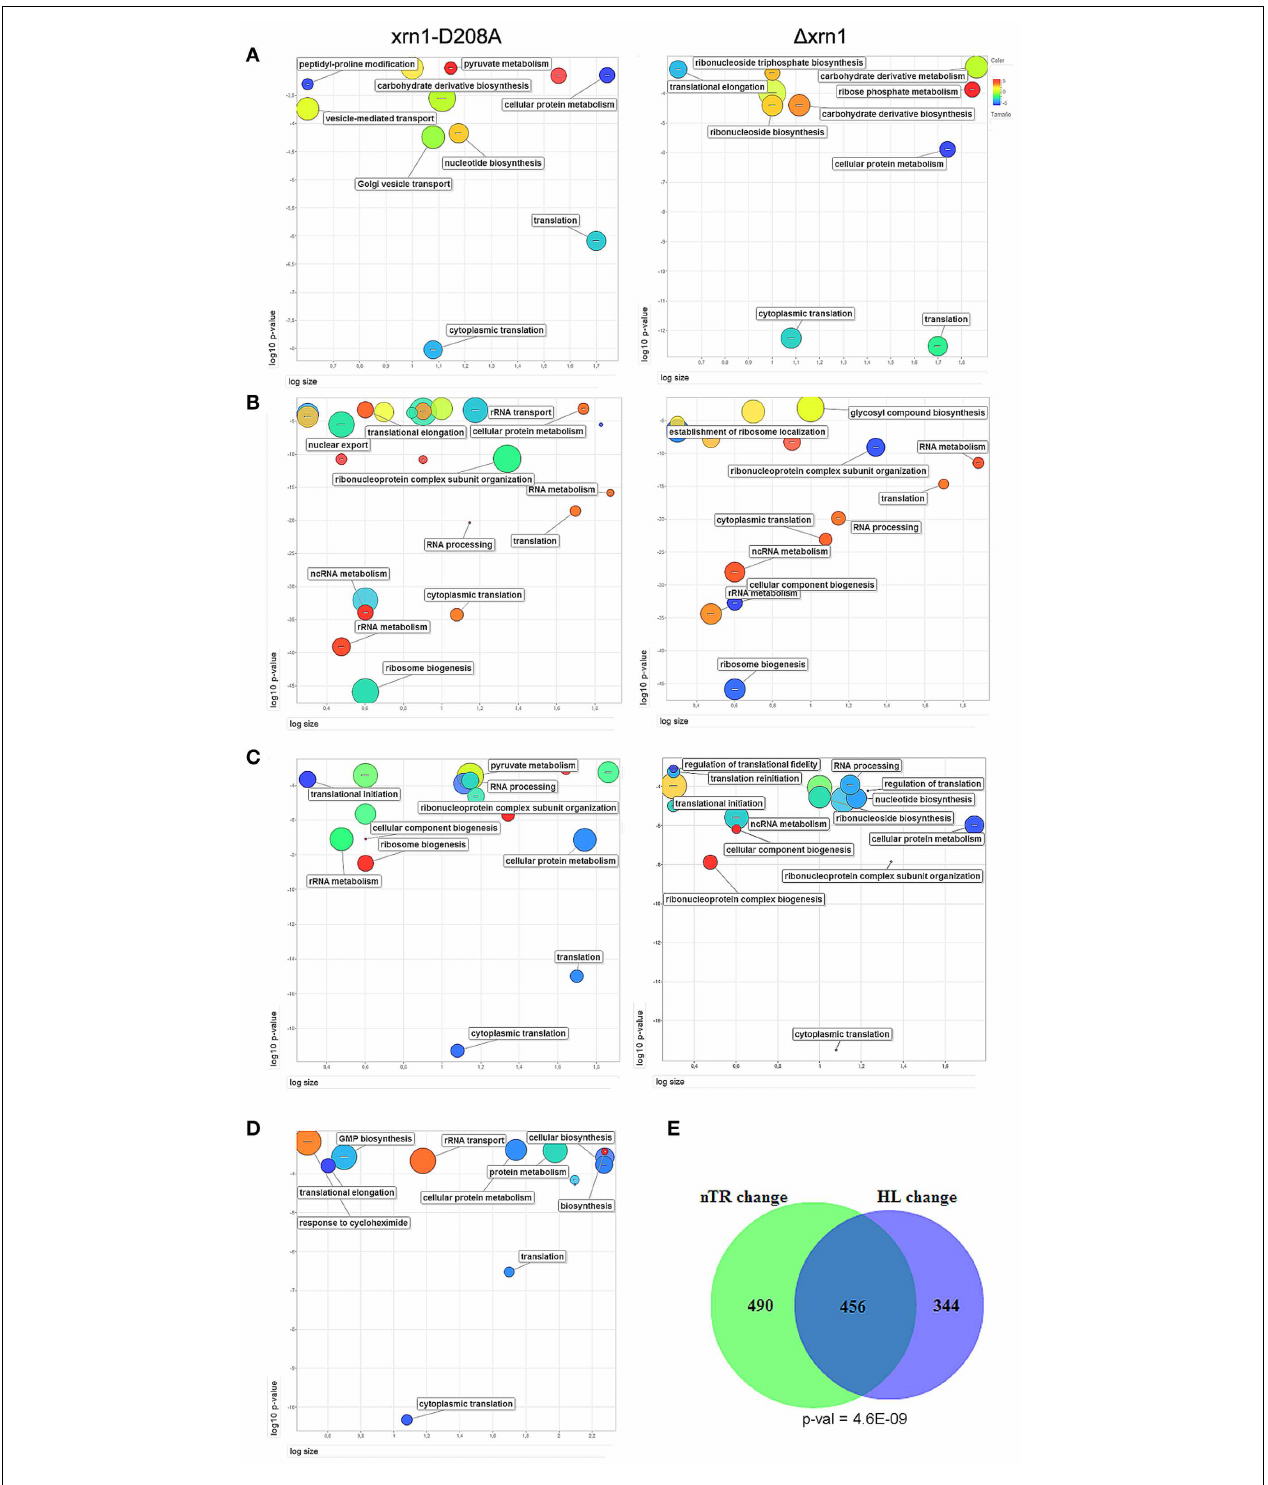
FIGURE 2 | ReViGO plots of the GO searches. Plots of the statistically overrepresented GOs among genes in the highest 20% change in the mutant against wt in the thiolutin HL determination (A) or nTR (B) . A similar search for the genes with responsiveness ≥ 8 (C) and the genes bound by Xrn1 (D) . ReViGO plots use previous GOrilla results for the Biological Process and plot the GO categories according to their p -value